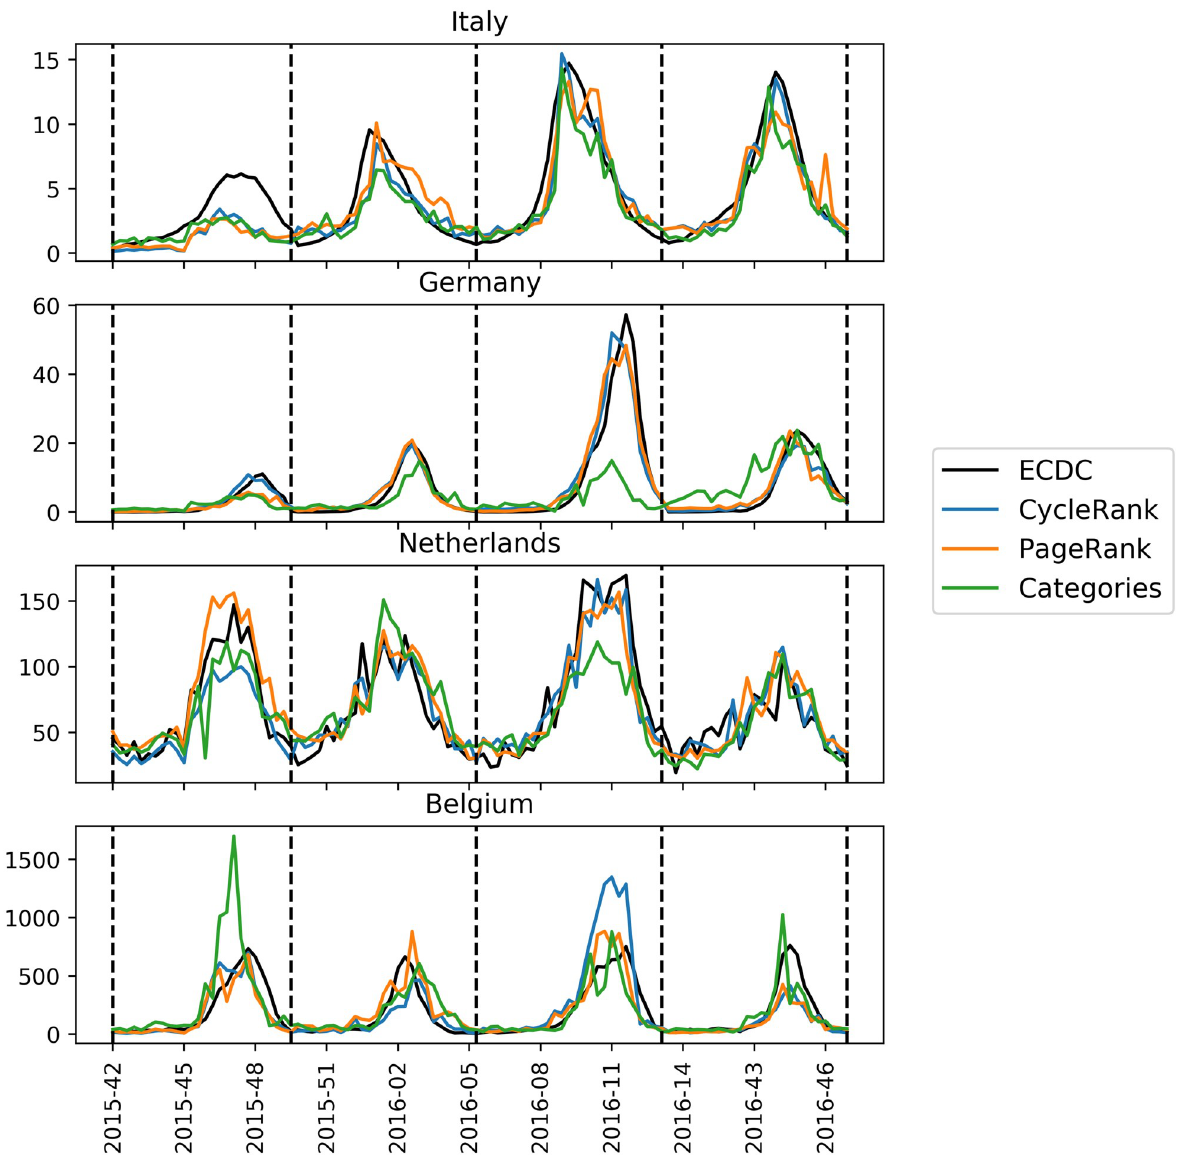
Fig 2. Best CycleRank , PPageRank and Categories GLM models predictions on the Italian, German, Belgian and Dutch influenza incidence. The dashed lines delimit the various influenza seasons.